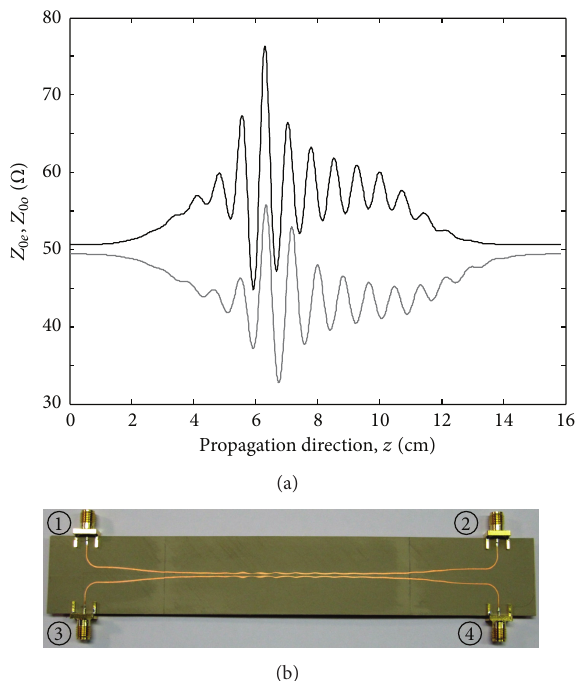
Figure 16: (a) Even (black line) and odd (grey line) characteristic impedance of the 4th-order differentiator after the compensation process and (b) the corresponding photograph of the prototype in microstrip technology for the given characteristic